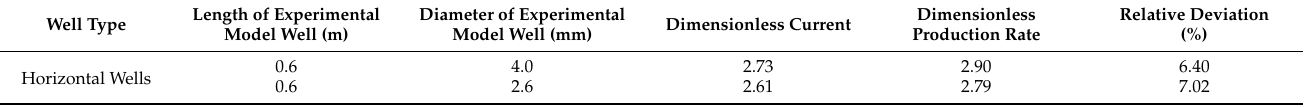
Figure 7. Electric simulation experimental schematic diagram. Table 3. Comparison of the results between experimental model and semi-analytical model for The experimental model and the corresponding actual model parameters are shown in Table 2. horizontal wells.